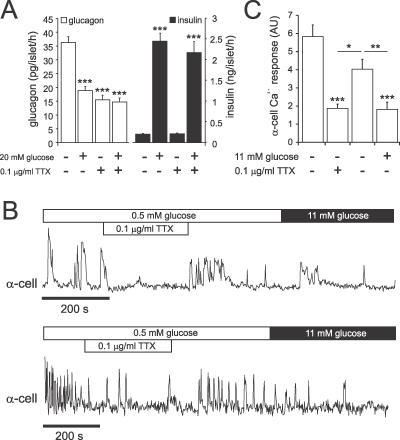
Glucagon Secretion and α-Cell Ca2+ Responses Are Dependent upon the Activity of Voltage-Dependent Na+ Channels(A) Glucagon (open bars) and insulin (filled bars) release from isolated mouse islets at 1 mM and 20 mM glucose, under control conditions and in the presence of the Na+ channel antagonist TTX (0.1 μg/ml).(B) Intracellular Ca2+ response of single α cells to 0.5 mM glucose. TTX (0.1 μg/ml) was included in the perfusion medium during the indicated period.(C) The effects of TTX and glucose on α-cell Ca2+ responses. Note that TTX inhibits Ca2+ responses as effectively as glucose and that the action is at least partially reversible.*, p < 0.05; **, p < 0.01; ***, p < 0.001, compared with controls, unless otherwise indicated.